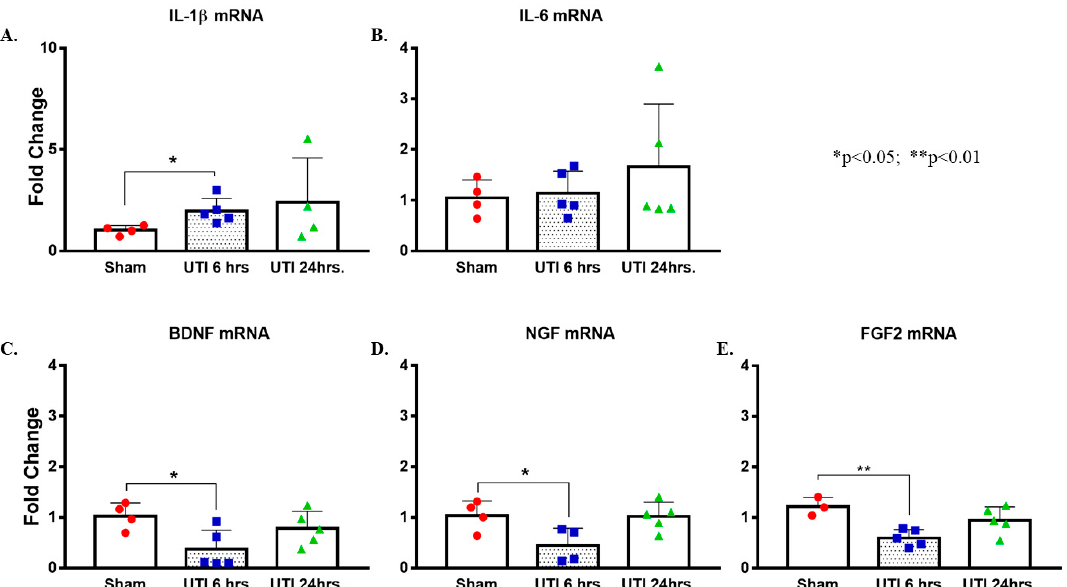
Figure 9. UTI elevated mRNA expression of Il - 1 β and decreased that of Bdnf , Ngf, and Fgf2 . ( A , B ) Increased expression of Il - 1 β mRNA with no changes in Il - 6 in hippocampi of rats with a UTI versus sham rats, unpaired Student’s t -test. ( C – E ) Decreased expression of Bdnf , Ngf, and Fgf2 mRNA in the hippocampi of rats with a UTI versus sham hippocampi detected at 6 h post infection. One-way ANOVA followed by Tukey’s multiple comparison test, p = 0.034, p = 0.049, and p = 0.007, respectively.